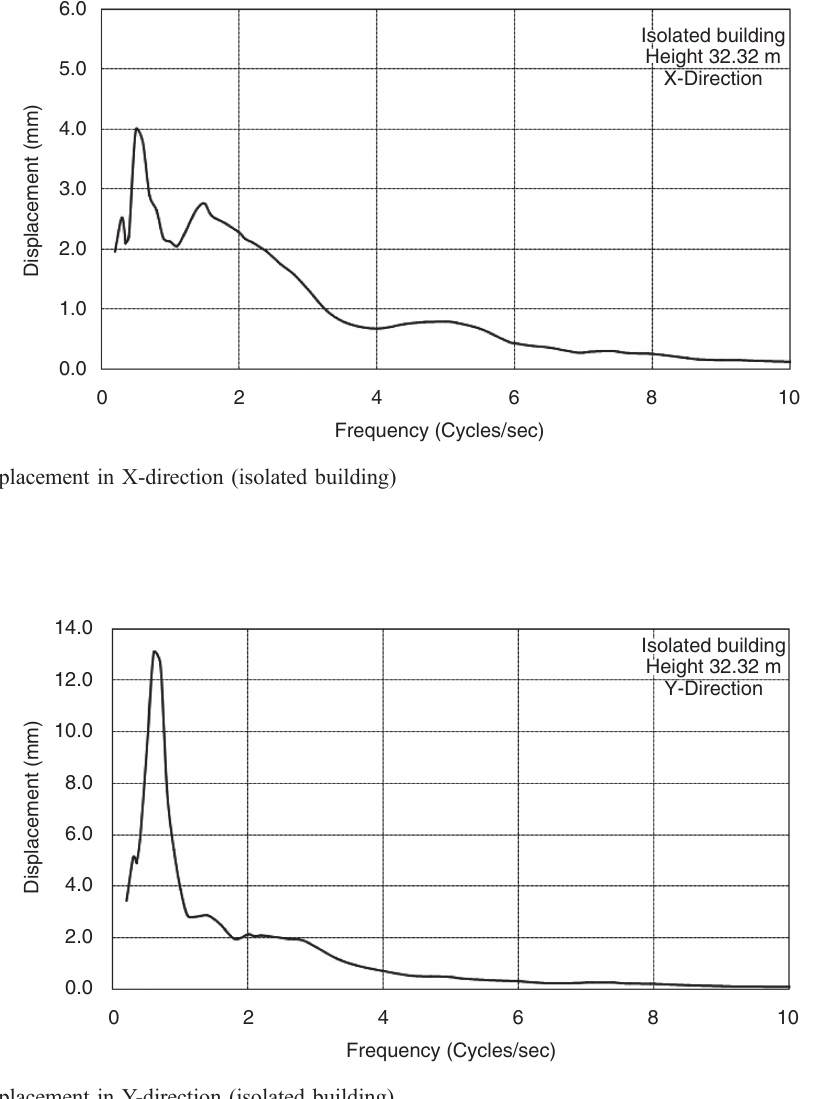
Fig. 17. Spectral Displacement in Y-direction (isolated building)